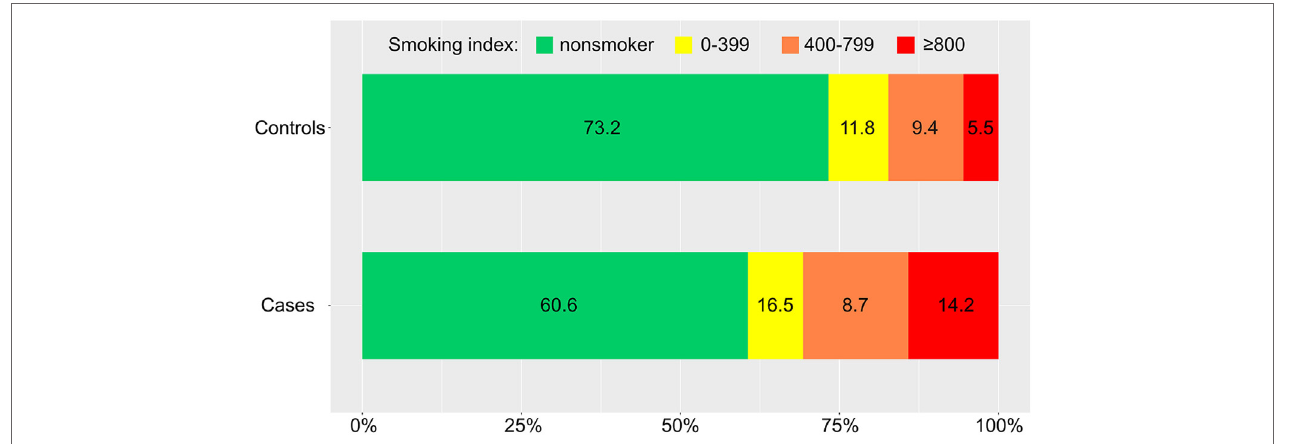
FigUre 3 | Distribution of smoking index (number of cigarettes smoked per day × years of smoking) in cases and